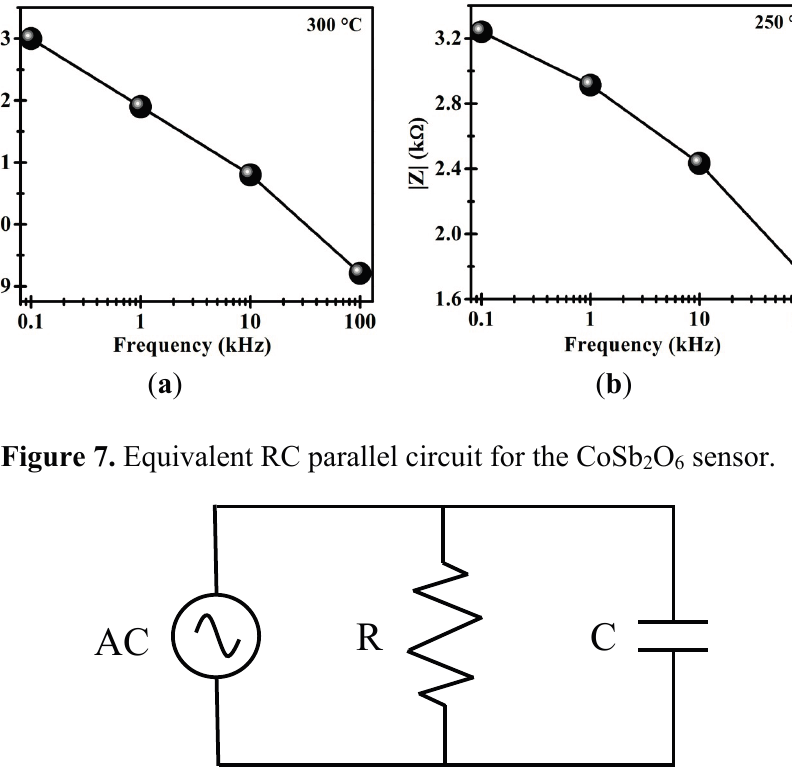
Figure 6. Impedance |Z| vs. frequency tests of the CoSb ( b ) 300 °C with air/CO